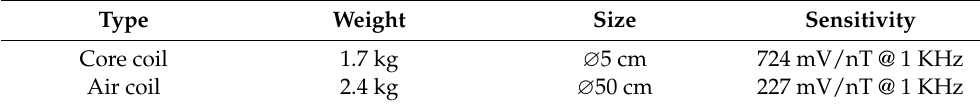
Table 1. Maximum detection time length according to the instrument detection threshold.